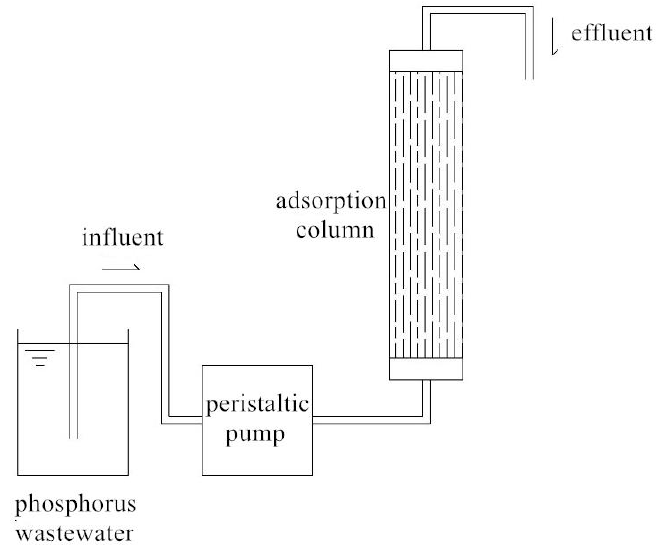
Figure 1. Schematic diagram of the dynamic adsorption experimental apparatus.